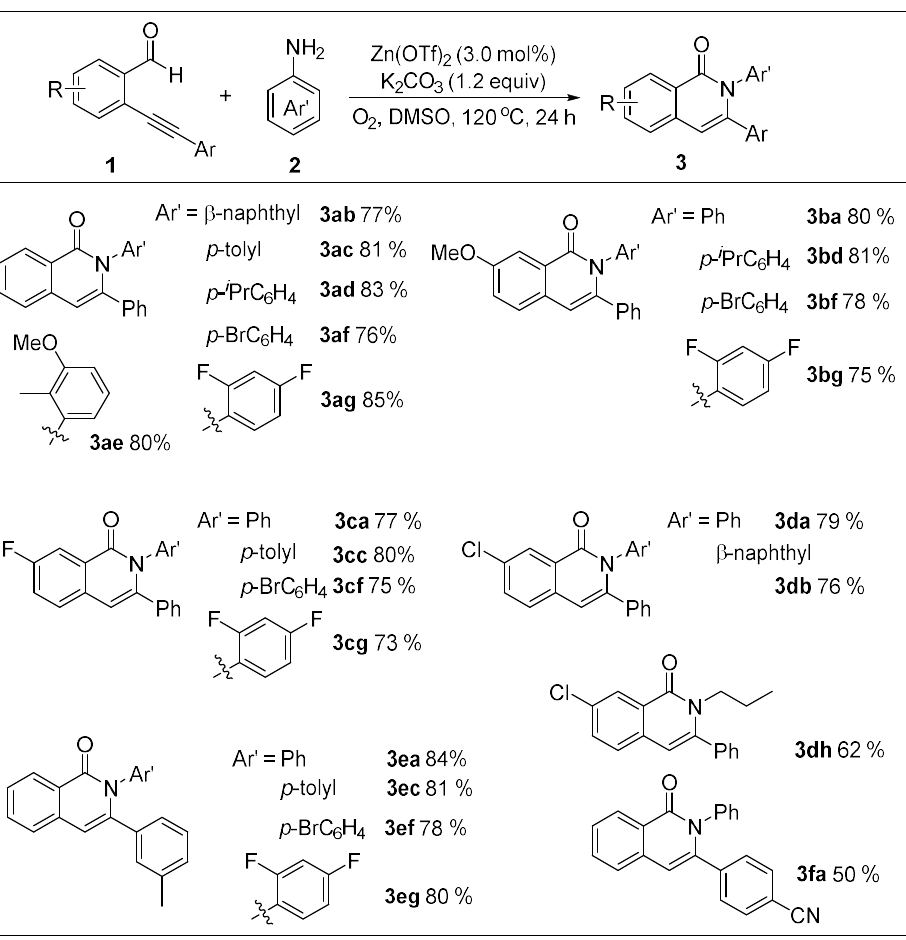
Table 2. Substrate scopes for the formation of isoquinolin-1(2 H )-ones a